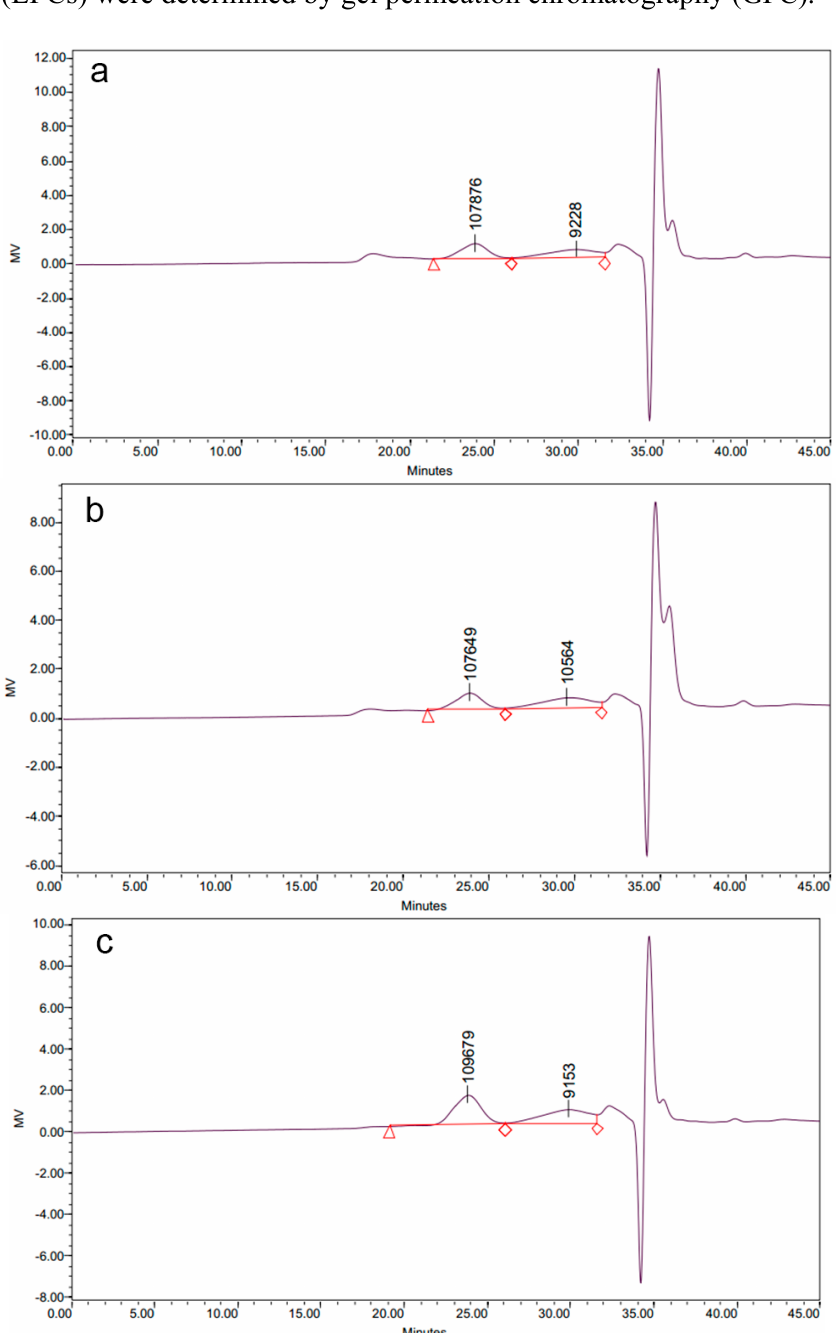
Figure 1. The molecular weight distribution of litchi polysaccharide-protein complexes from vacuum freeze dried pulp (LP-VF) ( a ), litchi polysaccharide-protein complexes from vacuum microwave dried pulp (LP-VM) ( b ), litchi polysaccharide-protein complexes from heat pump dried pulp (LP-HP) ( c ). The average molecular weights of litchi polysaccharide-protein complexes (LPCs) were determined by gel permeation chromatography